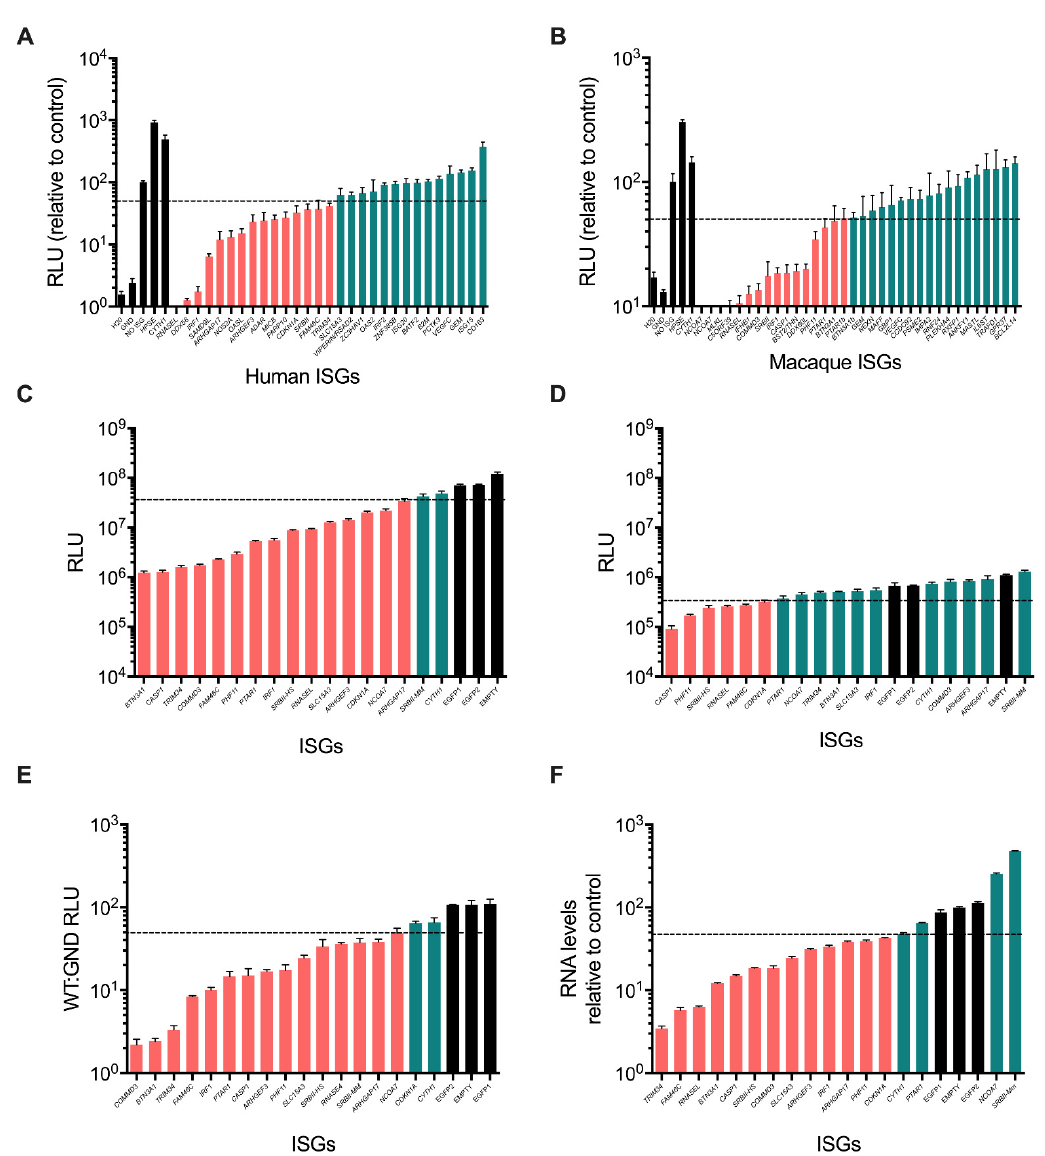
Figure 2. Secondary screen validation of anti-HCV-SGR ISGs from humans and rhesus macaques detected in the initial screen. ( A , B ) RLU detected at 72 hpt in HCV-SGR RNA (wild-type [WT]) transfected cells expressing human ( A ) or rhesus macaque ( B ) ISGs. ( C , D ) Validation of anti-HCV- SGR activity of human and rhesus macaque ISGs against WT ( C ), or replication-defective HCV-SGR RNA ( D ) at 72 hpt. The ratio of WT:GND RLU ( E ) and HCV RNA levels ( F ) was calculated at 72 hpt. For the data in panel F, WT HCV-SGR RNA was measured by RT-qPCR following electroporation of SGR RNA into stable puromycin-selected ISG-expressing Huh7 cell lines. Negative controls are shown (black) and ISGs that gave a >2-fold reduction in HCV RNA replication are indicated (pink). ISGs that do not achieve this threshold are shown in green. Values from triplicate wells as technical replicates were used and variation is shown as standard error of the